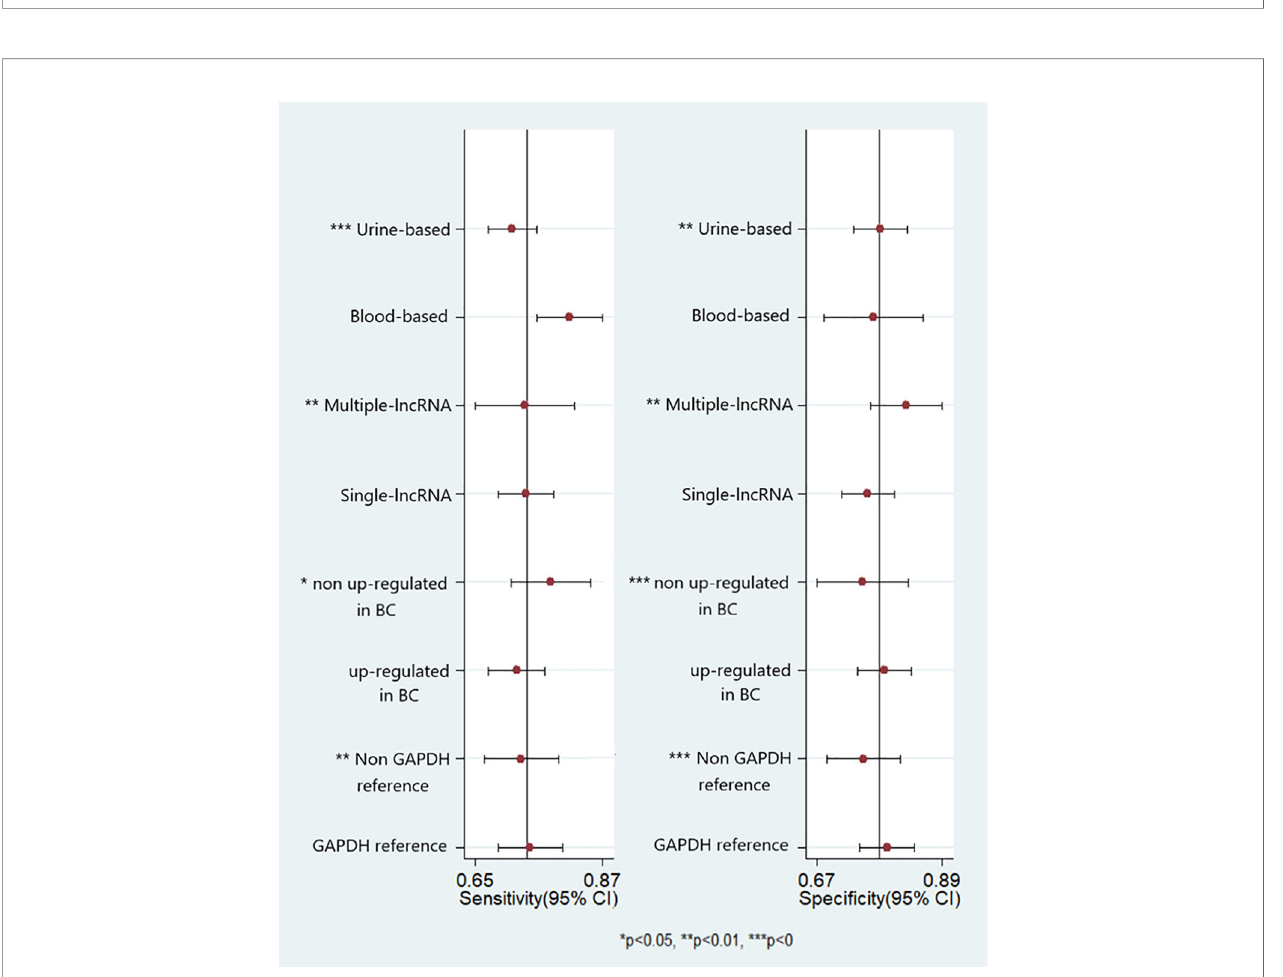
FIGURE 5 | Forest plots of multivariable meta-regression analyses for sensitivity and speci fi city (vertical lines signify pooled estimates of sensitivity and speci fi city respectively).